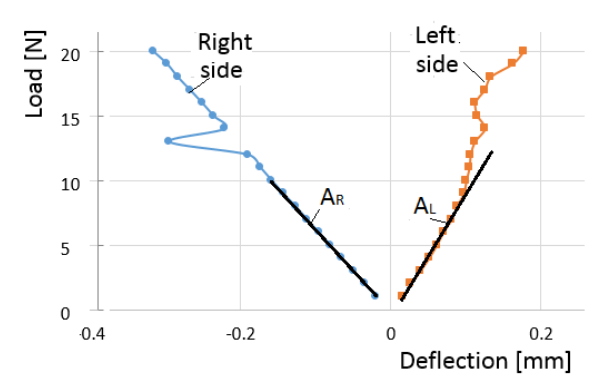
Figure 9: Degree of change in the stiffness non-linearity. Source: Own study. Table 3: Change of initial